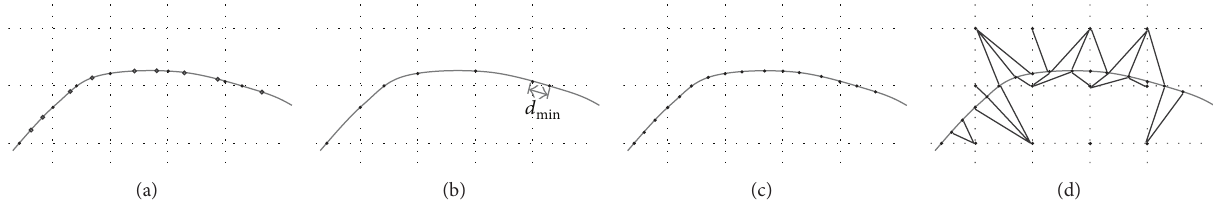
Figure 10: Meshing algorithm. (a) Original intersection curve and intersection points (black and white points are the intersection points on implant and spine models, resp.). (b) Intersection points on implant models. (c) Intersection points reconstruction. (d) Triangulation.